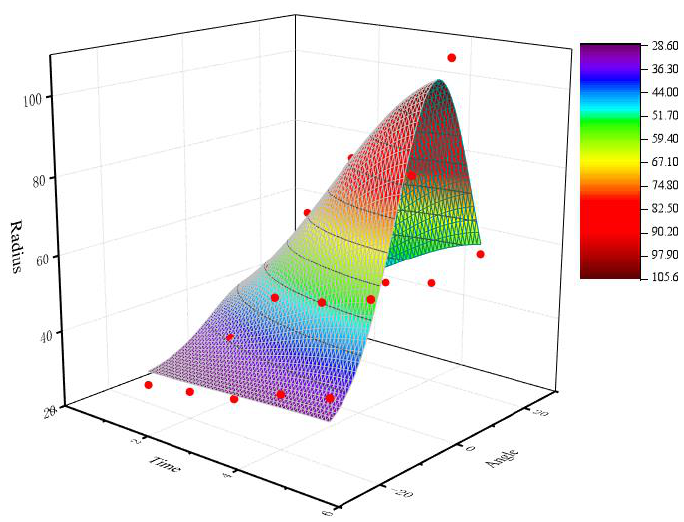
Figure 21. Fitting surface diagram of model 1.